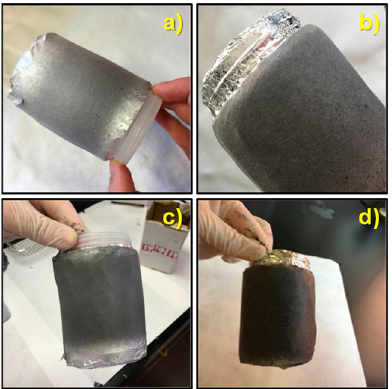
Figure 1. Images of solution blow-spun PBSe:LDI:PD polyurethane-based nanocomposites on the collector: ( a ) 0.5%; ( b ) 1.0%; ( c ) 2.0%; ( d ) 3.0% by weight of